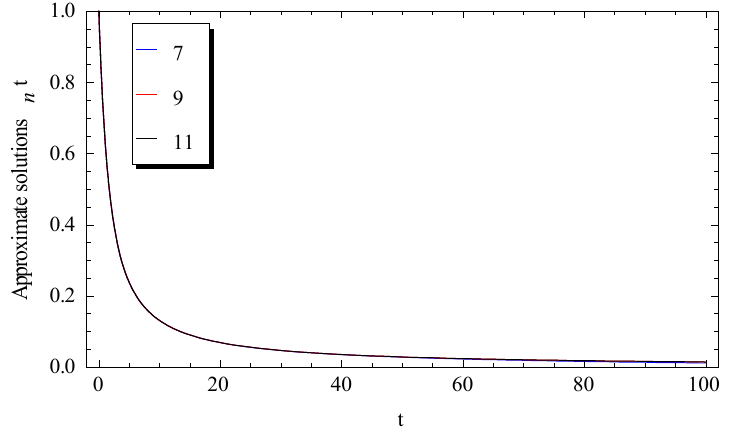
Figure 3. Convergence of the Adomian approximate solutions at λ = 1 and q = 2 .